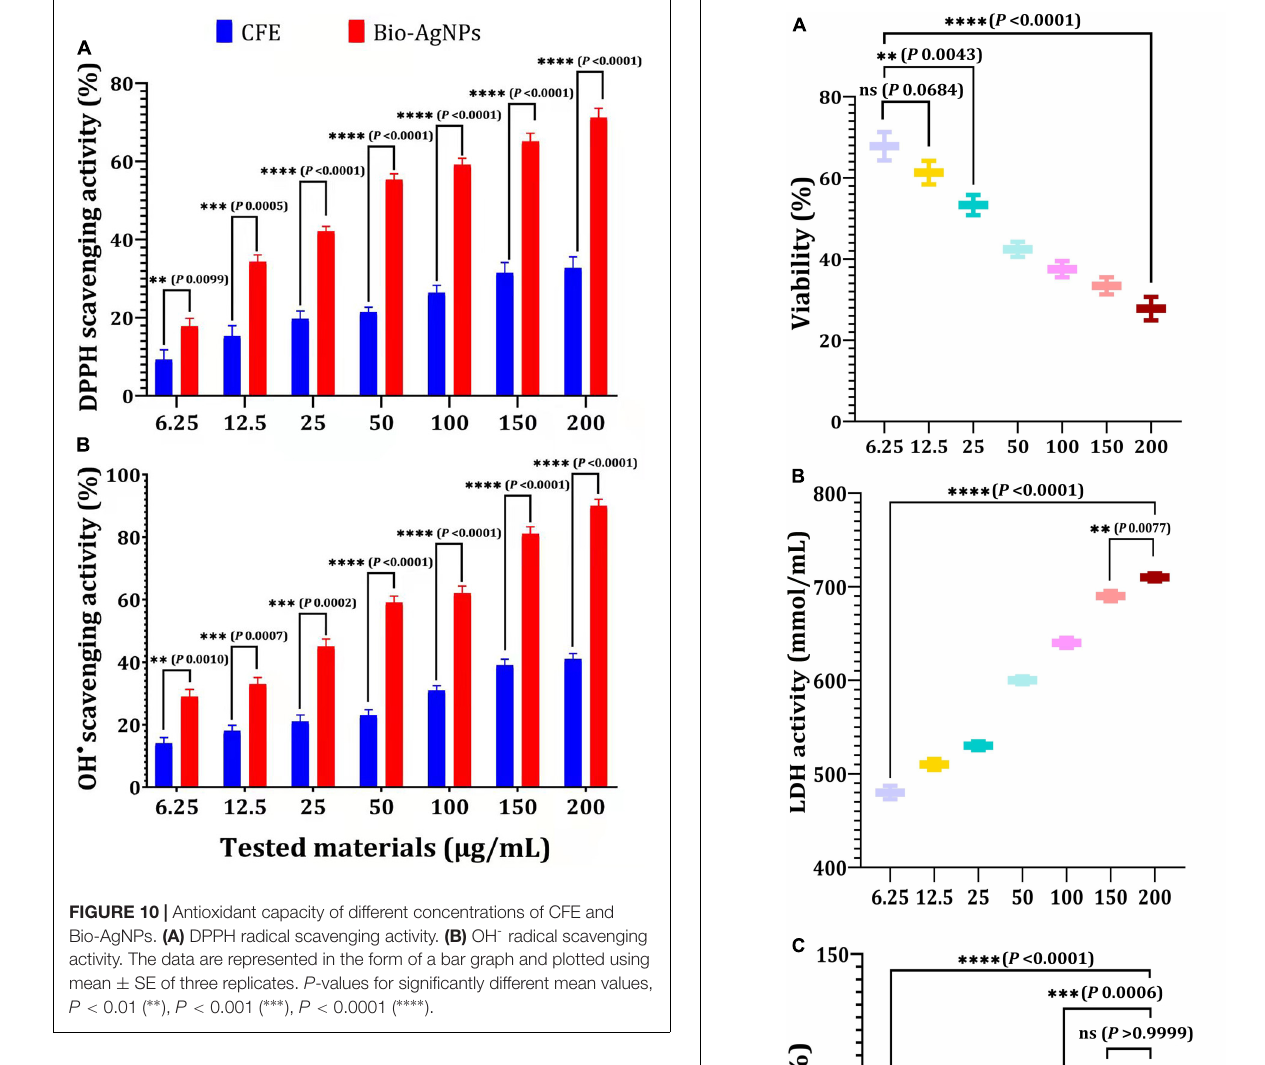
Frontiers in Microbiology |